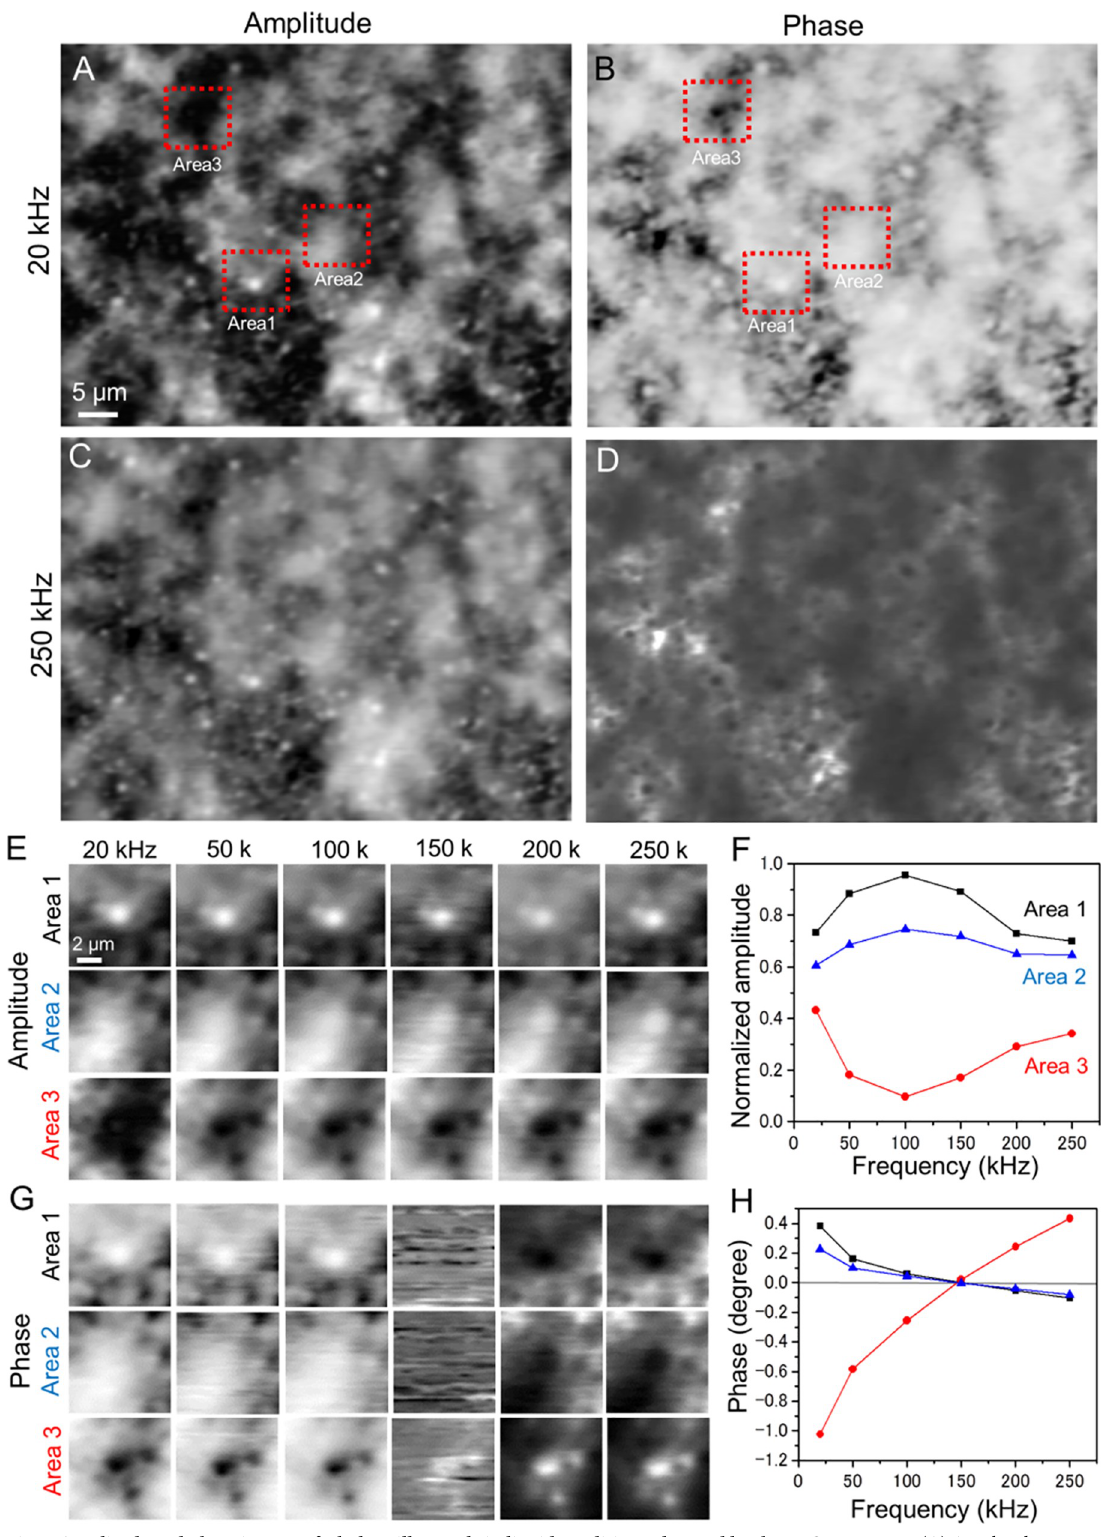
Fig 5. Amplitude and phase images of whole-milk sample in liquid conditions observed by the IP-SEM system. (A) Amplitude image of the whole-milk sample (input frequency 20 kHz, EB accelerating voltage 7 kV, EB current 500 pA, magnification 1,000 × ). Black and